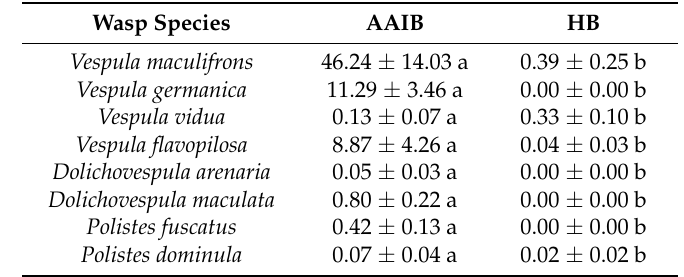
Table 2. Mean ± SEM number of social wasps captured per trap baited with acetic acid and isobutanol (AAIB) or heptyl butyrate (HB) from 20 July through 2 November 2017 in South Central Wisconsin